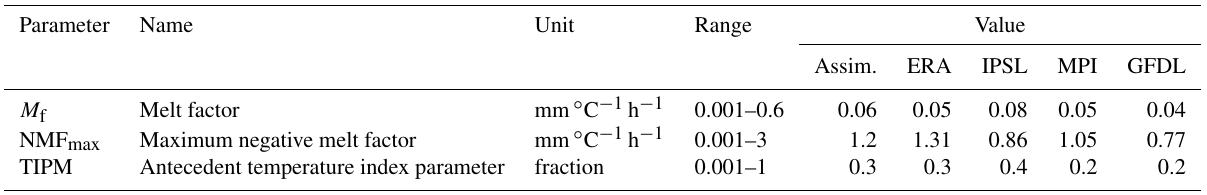
Table A2. Snow model parameters: allowable range and calibrated values for the different simulations.